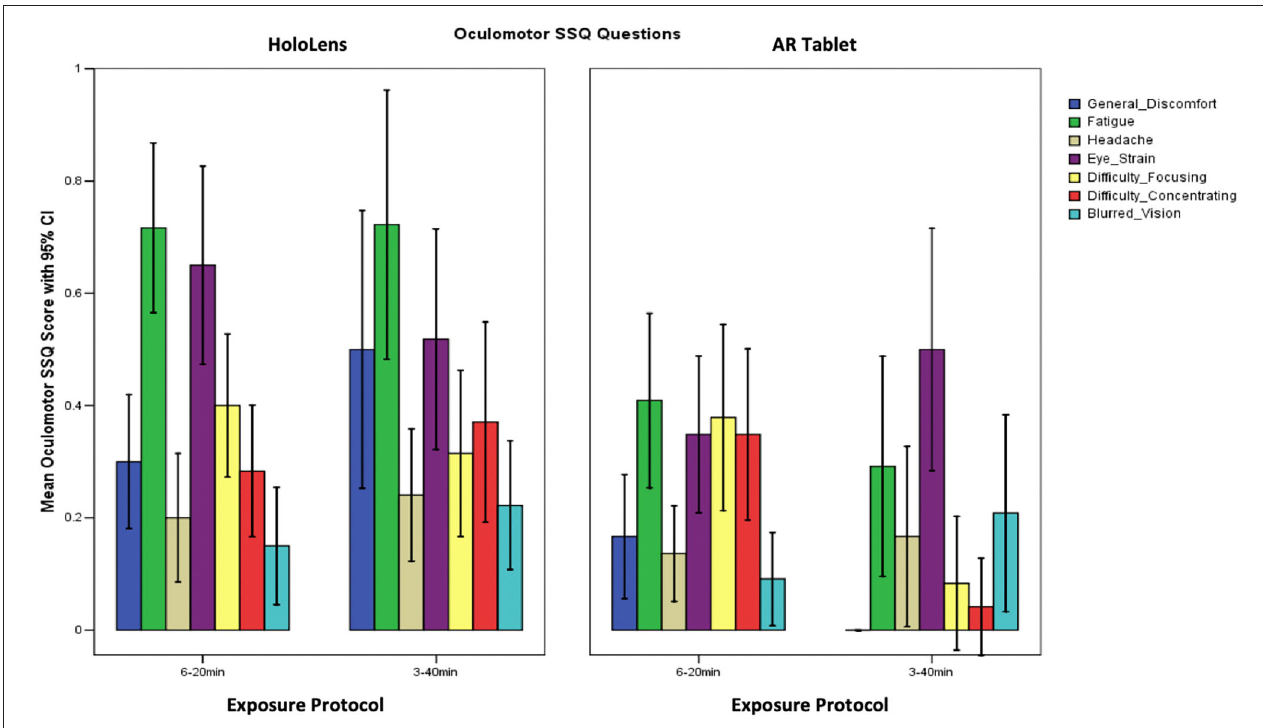
FIGURE 3 | Mean oculomotor SSQ question scores with 95% CI.